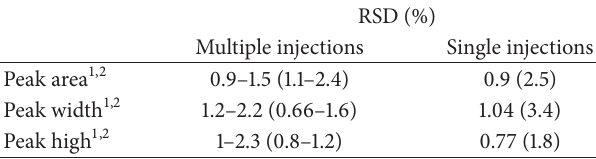
Table2:Performancecomparisonforsingleandmultipleinjections.